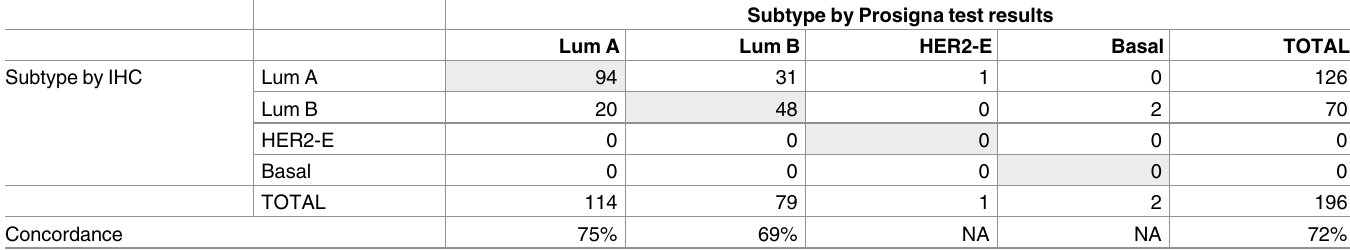
Table 2. Intrinsic tumor subtype results by physician judgement and Prosigna test results.